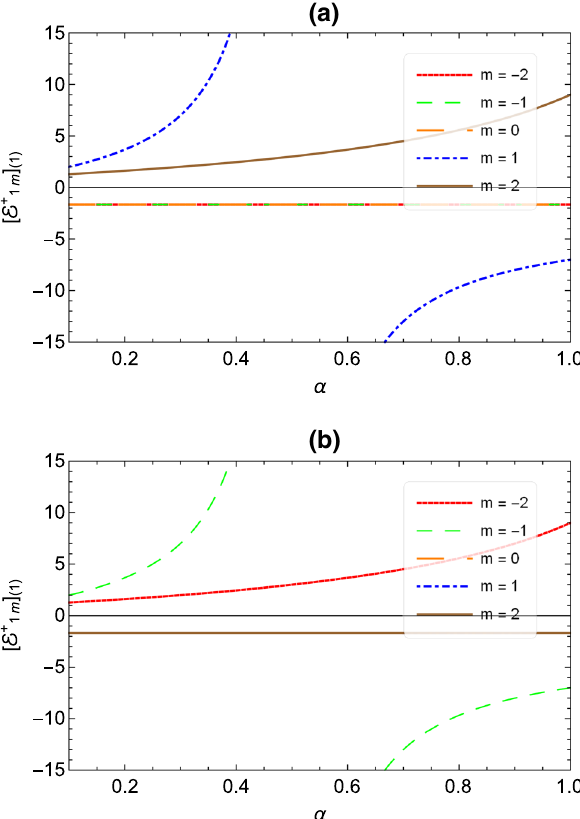
Fig. 3 Illustration of the energy levels in the spin symmetry limit, (cid:8) (cid:9) E + , as a function of the parameter α for the particular case when 1 m p = 0. In a the plot for s = 1 and b for s = − 1. We use M = 1 and η L η = 1. In a the energies are degenerate for m = − 2 , − 1 , 0. Energy C is not defined in α = 0 . 5 when m = 1 (dashed green line). The energy value for m = 2 (solid brown line) and α → 0 increases while near α = 1 it decreases. The characteristics present in b are equivalent to